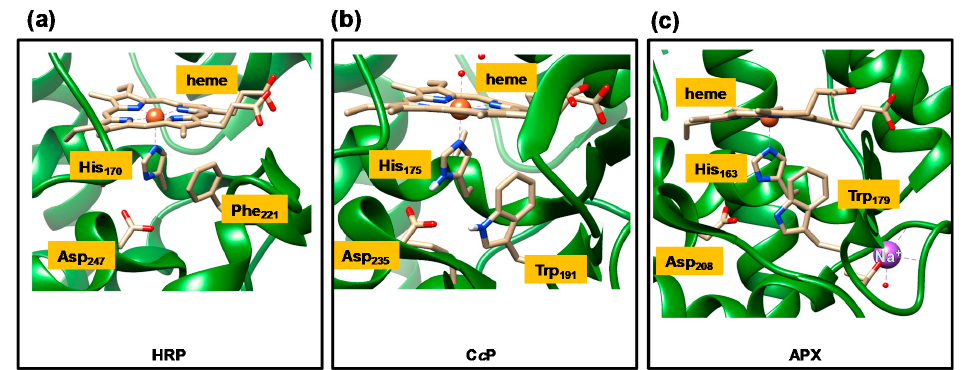
Figure 1. Active site structures of ( a ) horseradish peroxidase (HRP; 1H58 pdb), ( b ) cytochrome c peroxidase (C c P; 1CCA pdb), ( c ) ascorbate peroxidase (APX; 1OAF